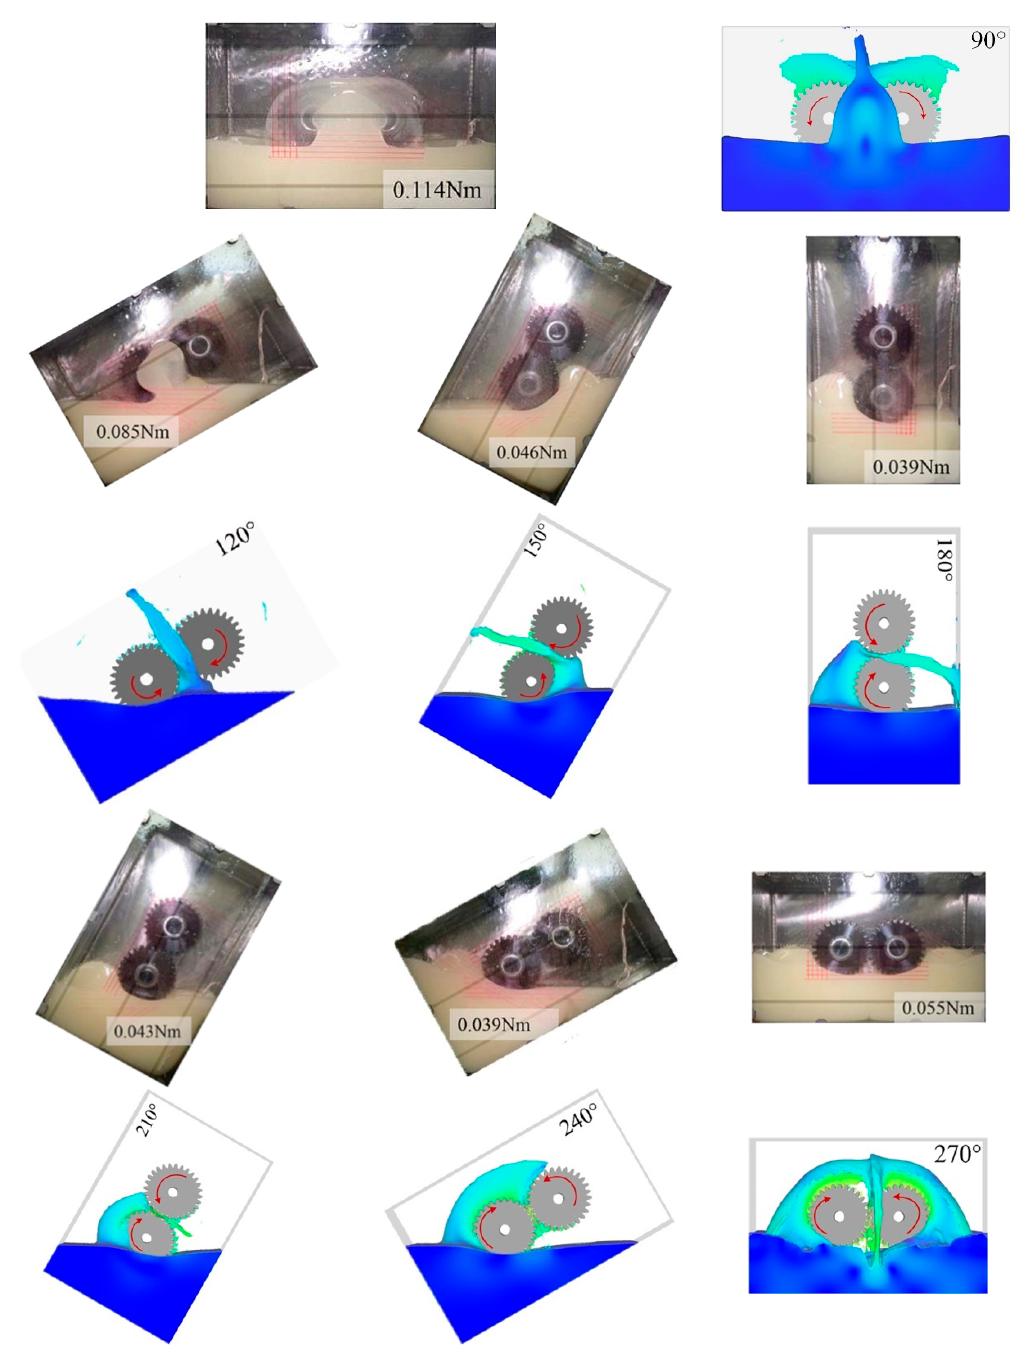
Figure 4. Comparison between numerical and experimental results for the oil free surface with different inclination angles.